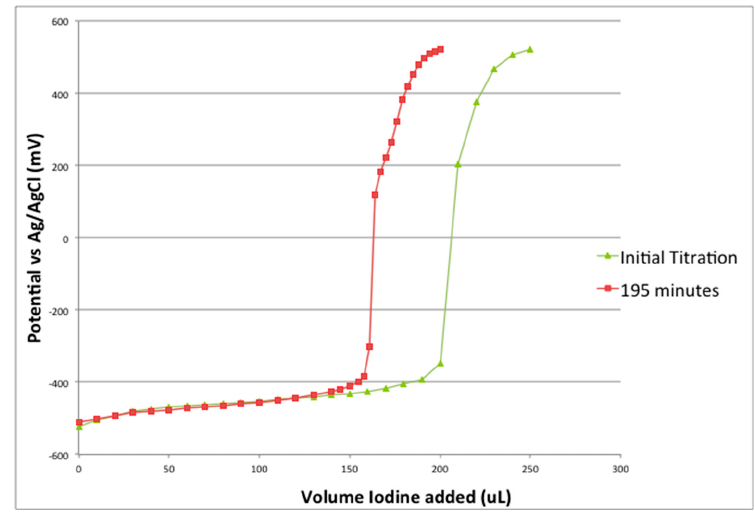
Figure 3. Potentiometric titration of KO 2 with iodine, I 2 .